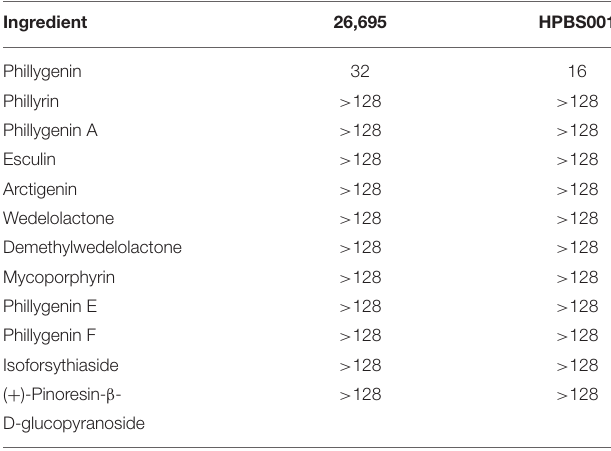
TABLE 1 | Minimum inhibitory concentrations (MICs) of 12 monomer components of Forsythia suspensa against Helicobacter pylori ( µ g/ml). Ingredient